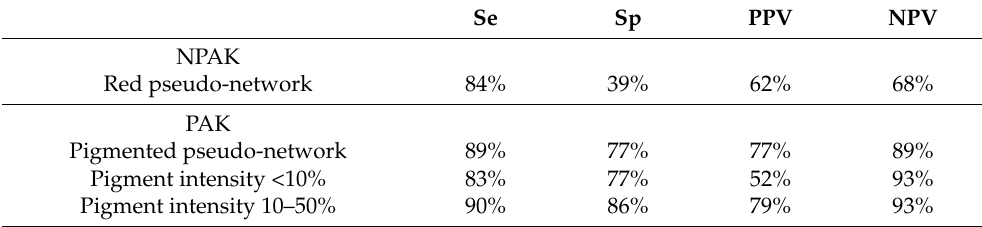
Table 3. Se, Sp, PPV, and NPV of significantly present dermoscopic criteria for NPAK and PAK. Se Sp PPV NPV NPAK Red pseudo-network 84% 39% 62% 68% PAK Pigmented pseudo-network 89% 77% 77% 89% Pigment intensity <10% 83%